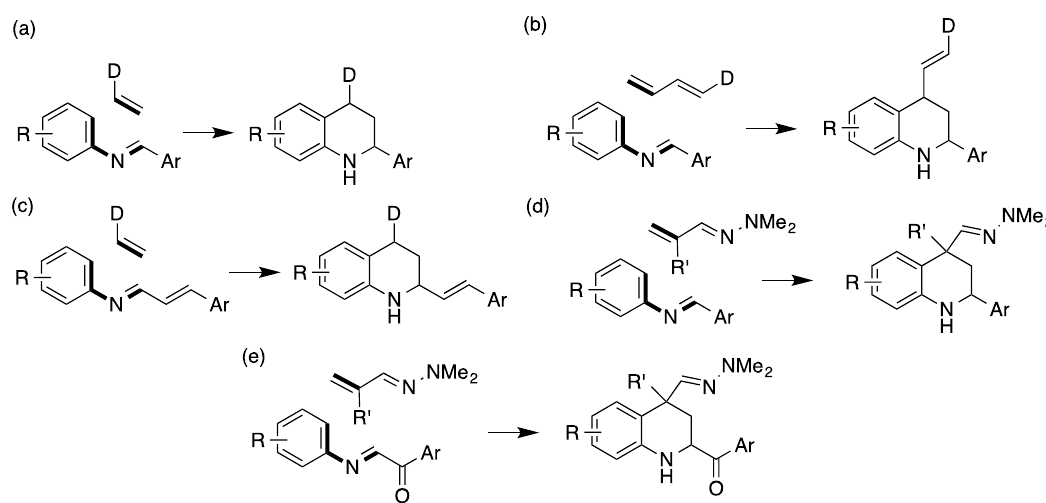
Figure 1. Selected natural and synthetic 1,2,3,4-tetrahydroquinolines.